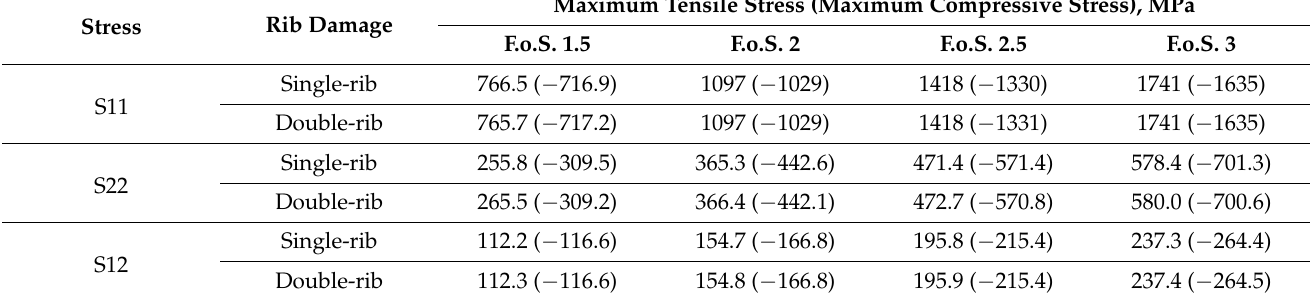
Table 21. Maximum values of stress components in the wing models containing rib damage.